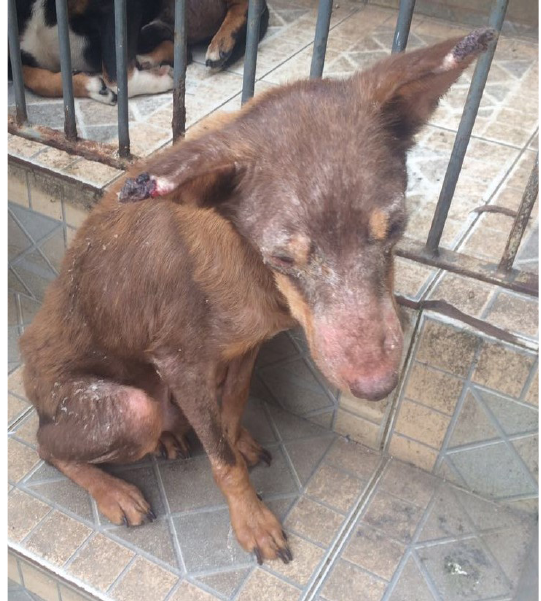
Figure 2. Animal with crustal lesions suggestive of Canine Visceral